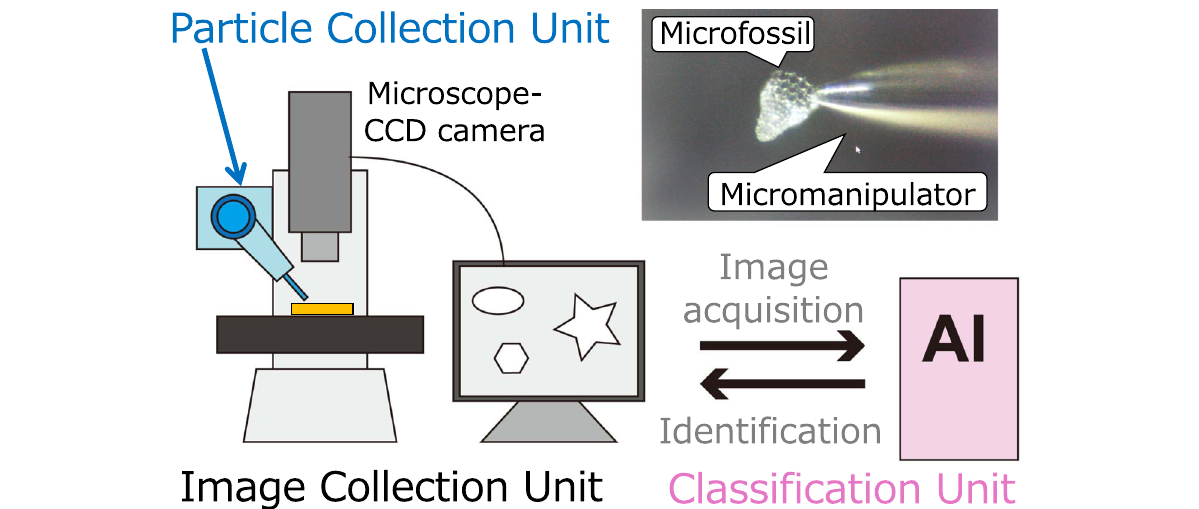
Fig. 1 Schematic of the automated microfossil collection system, which is composed of three units: Image Collection Unit, Classification Unit, and Particle Collection Unit. A photo of the system is shown in the upper right. Image scanning over the tray and picking up microfossils can be seen in Supplementary Movies 1 and